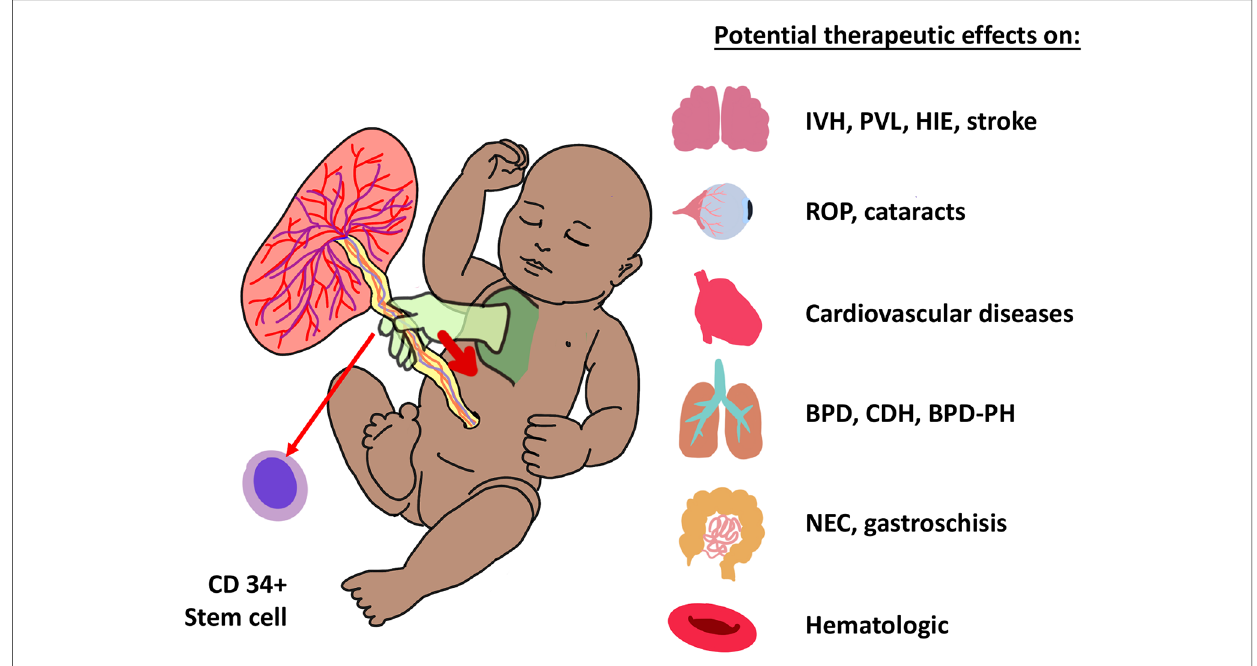
FIGURE 3 Umbilical cord milking (UCM) increases CD34+pluripotent stem cells in babies, which have potential bene fi ts as summarized in the fi gure. IVH, intraventricular hemorrhage; PVL, periventricular leukomalacia; HIE, hypoxic ischemic encephalopathy. ROP, retinopathy of prematurity; BPD, bronchopulmonary dysplasia; CDH, congenital diaphragmatic hernia; PH, pulmonary hypertension; NEC, necrotizing